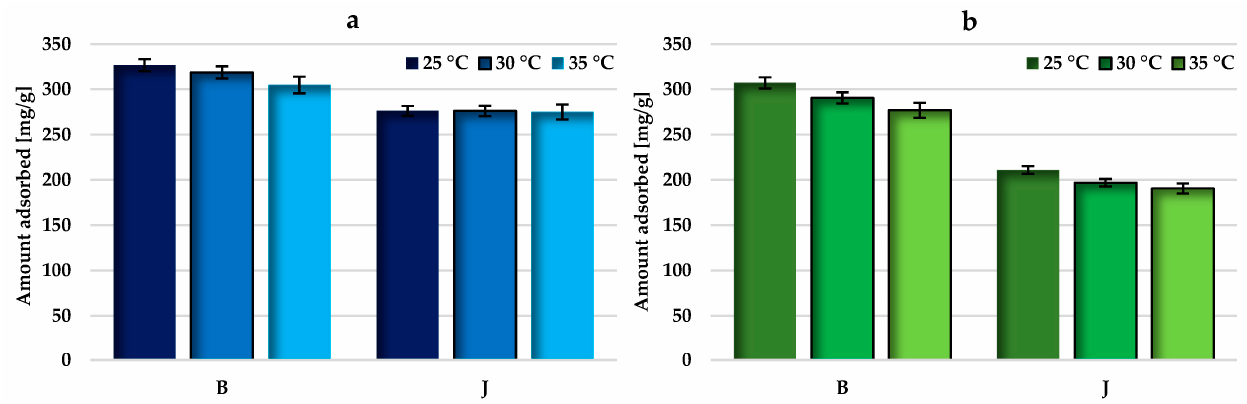
Figure 8. Effect of temperature on methylene blue ( a ) and malachite green ( b ) adsorption on the carbonaceous materials derived from the used carbon filters.